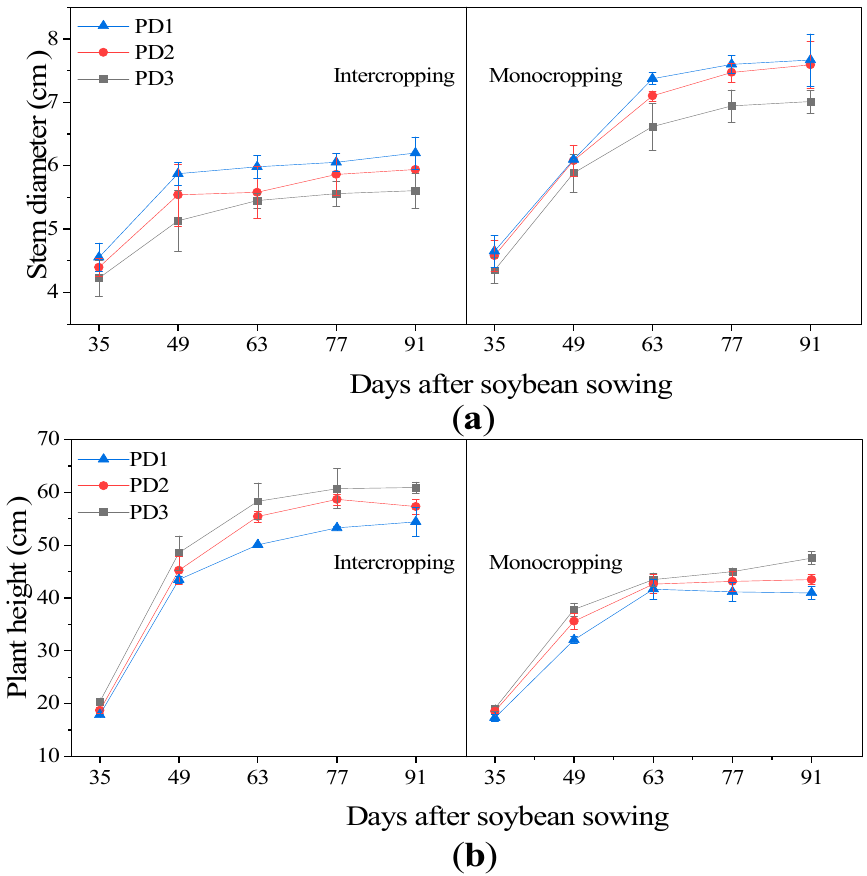
Figure 8. Effects of multiple planting densities (PD1 = 17, PD2 = 20, and PD3 = 25 plants m − 2 ) on stem diameter ( a ) and plant height ( b ) under both strip intercropping system and monocropping. All the values are means (±SE) standard error of three replications.